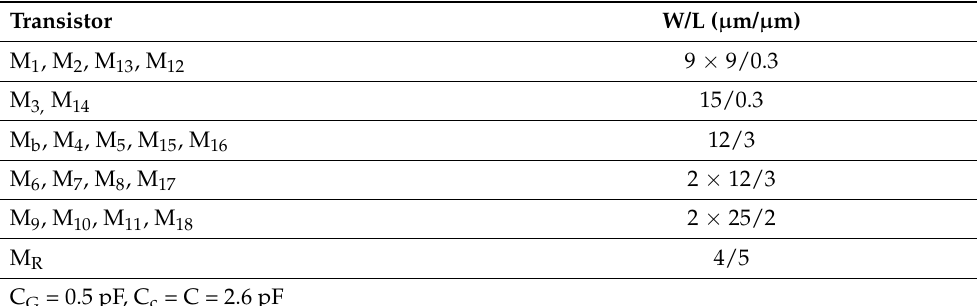
Table 3. Parameters of the components of DDTA in Figure